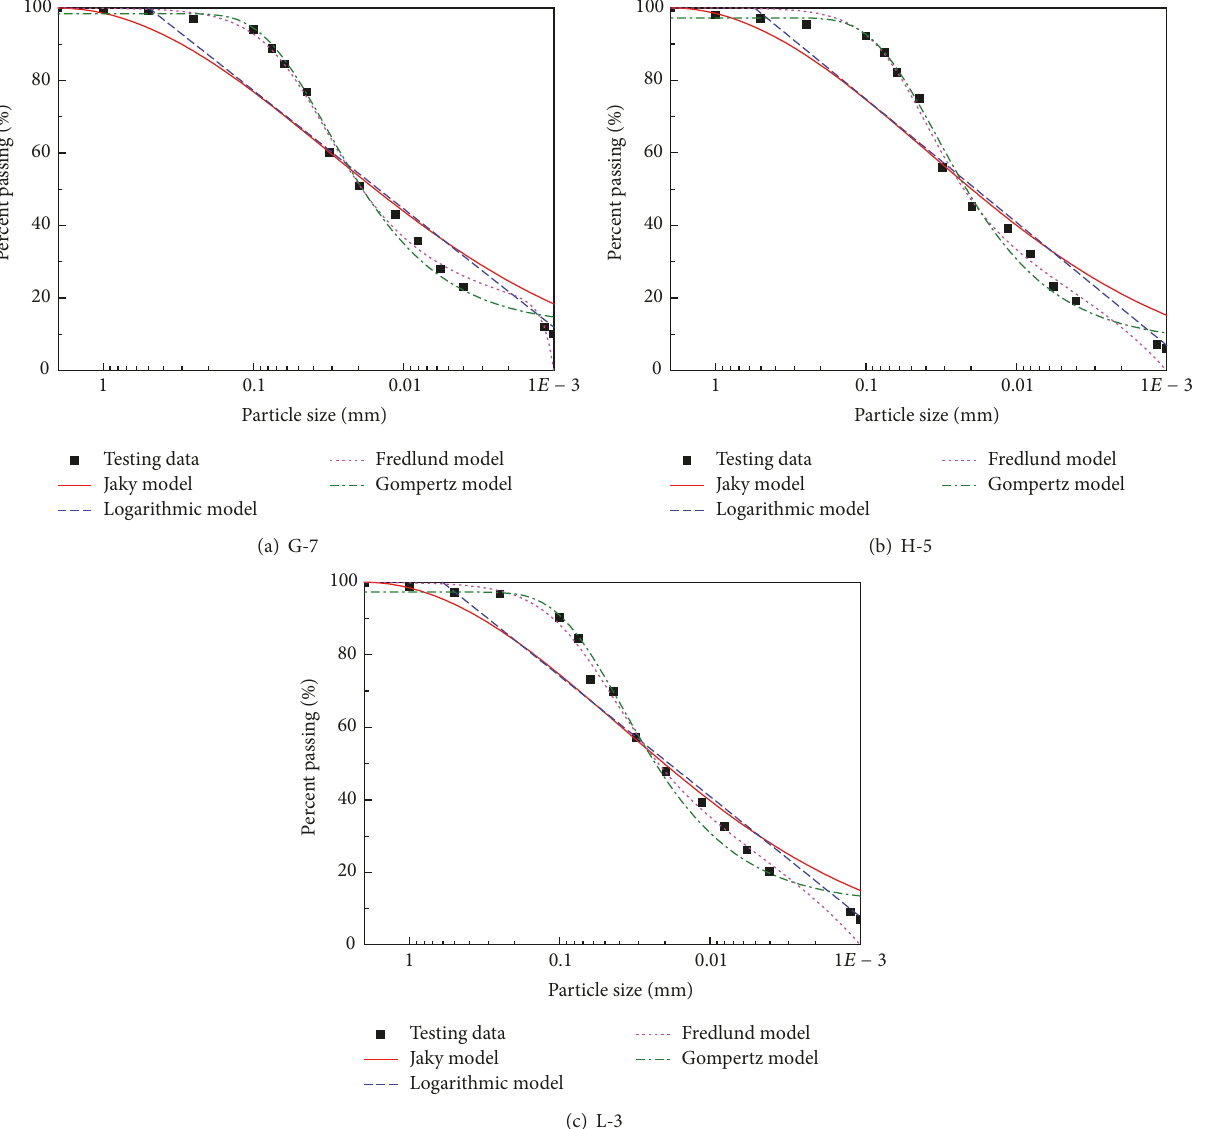
Figure 5: Performance of models fitted to sieve-pipette particle size